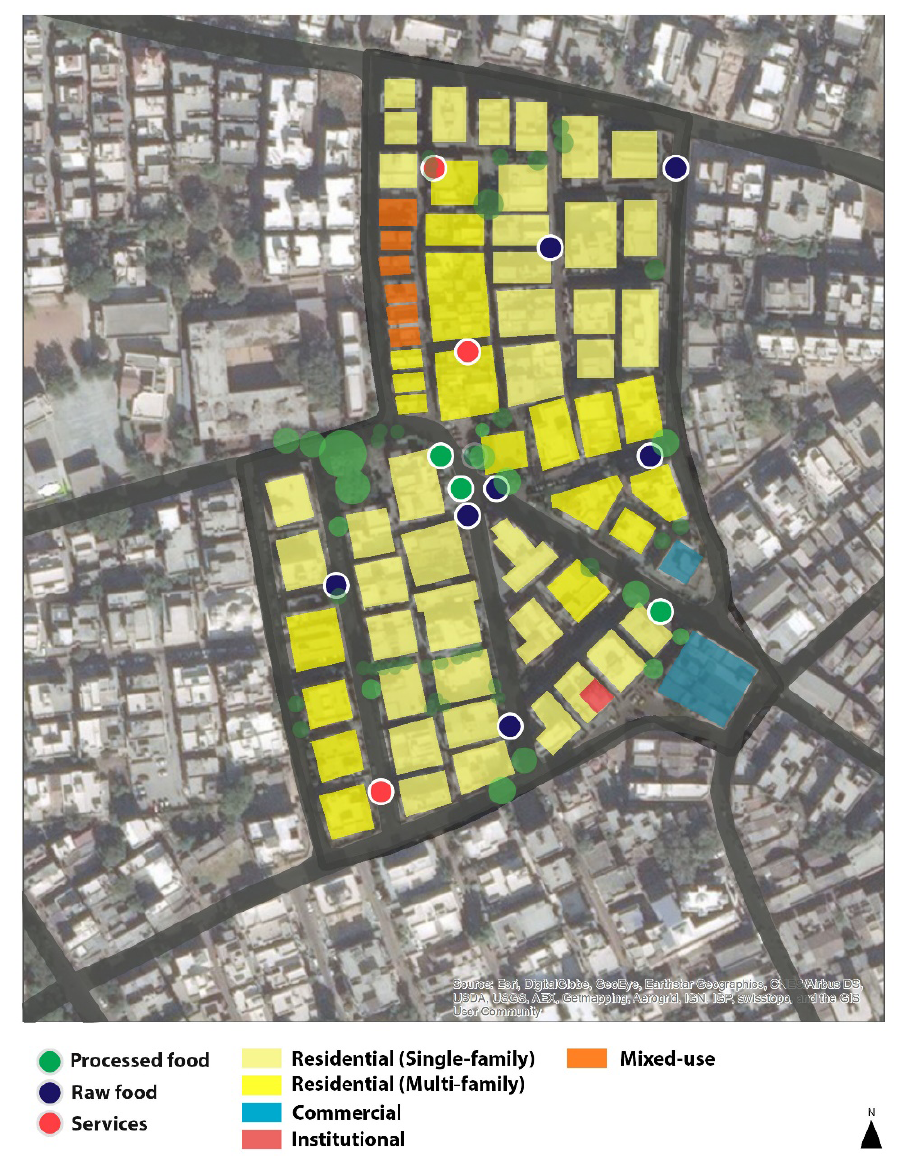
Figure 4. Street vendors in and around residential area in Sabarmati ward. Source: Field work. around late evenings. The vendors are clustered on the sidewalk along the park. Over 50 percent of vendors sell processed food, 30 percent sell fruits and vegetables, and around 20 percent sell clothes and